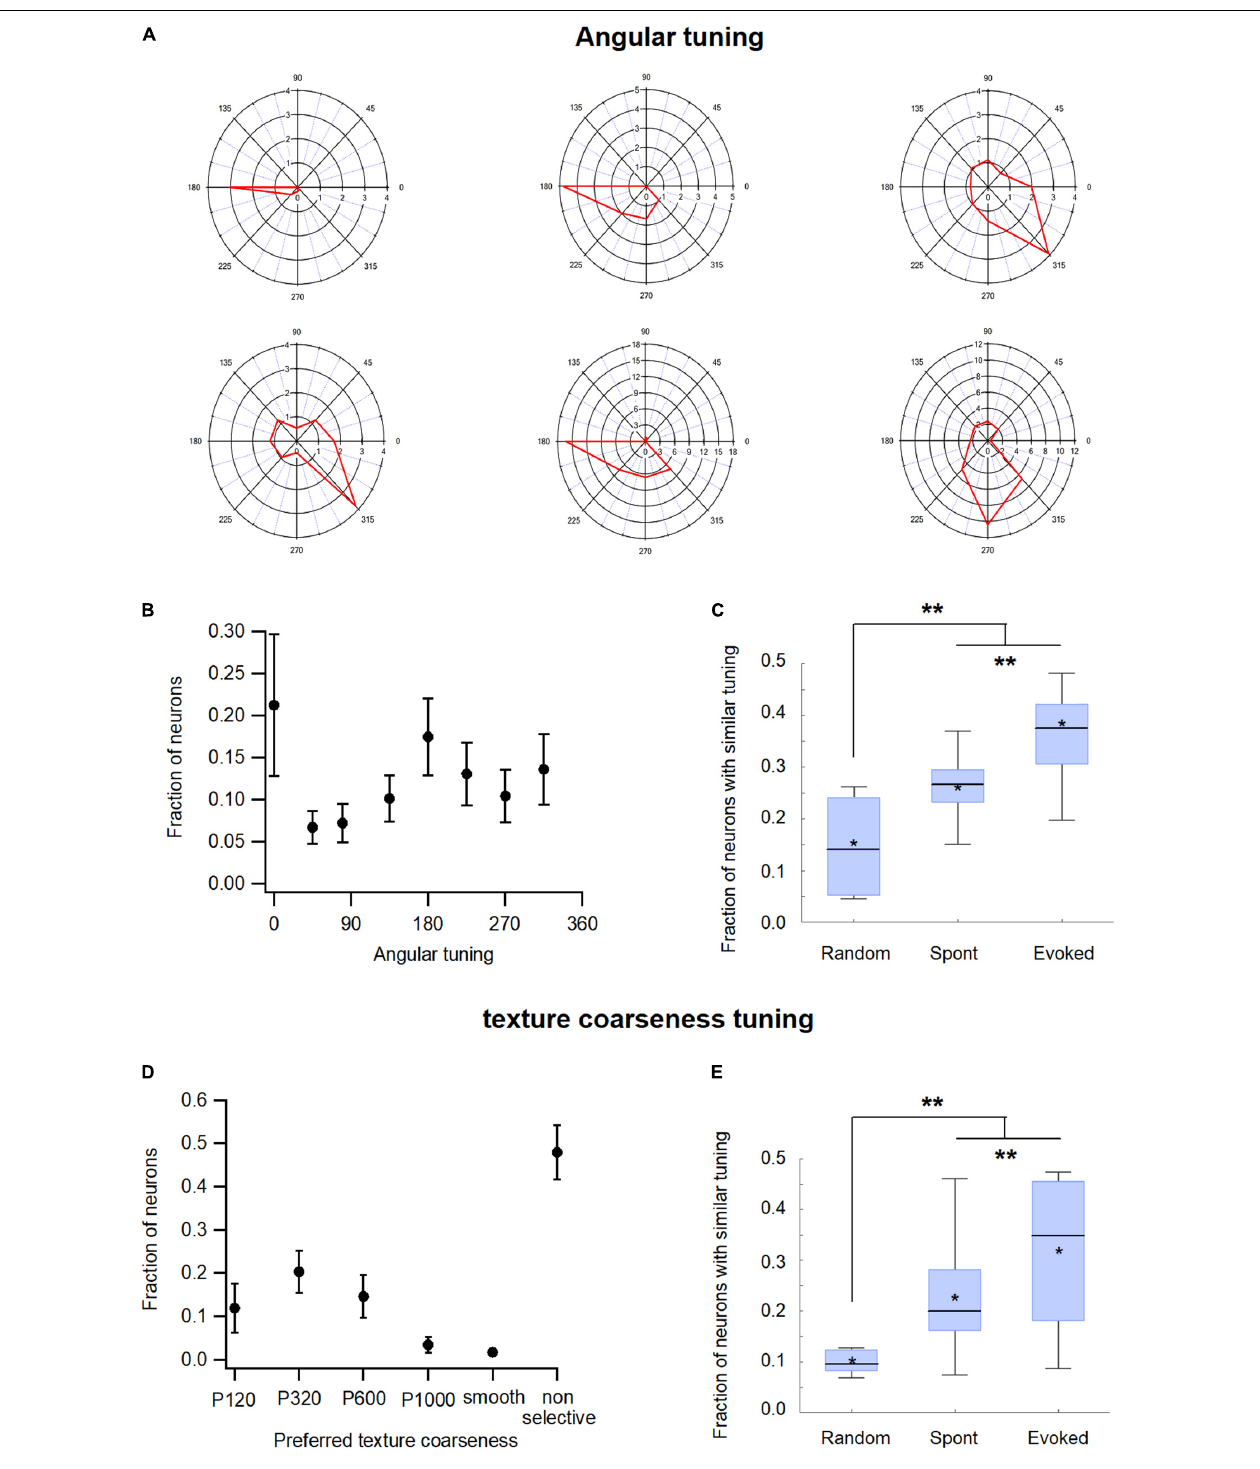
FIGURE 7 | Functional organization of the barrel wS1 cortex: Functional tuning properties. (A) Polar plots of six individual wS1 neurons during ramp-and-hold vibrissa deflection to eight different angles (0 ◦ , 45 ◦ , 90 ◦ , 135 ◦ , 180 ◦ , 225 ◦ , 270 ◦ , and 315 ◦ ). The average response of the neuron for each direction is plotted in red. (B) Distribution of the preferred angle in our neuronal population (213 units from 7 rats) presented as the average fraction of neurons ( M ± SEM ) preferring each of the eight angles in the ramp-and-hold passive stimulation. (C) Box plots of the fraction of functionally connected neurons, which share a similar preferred angle tuning measured during the spontaneous pre-stimulus and evoked activity states. In addition, the expected random value was calculated based on the distribution